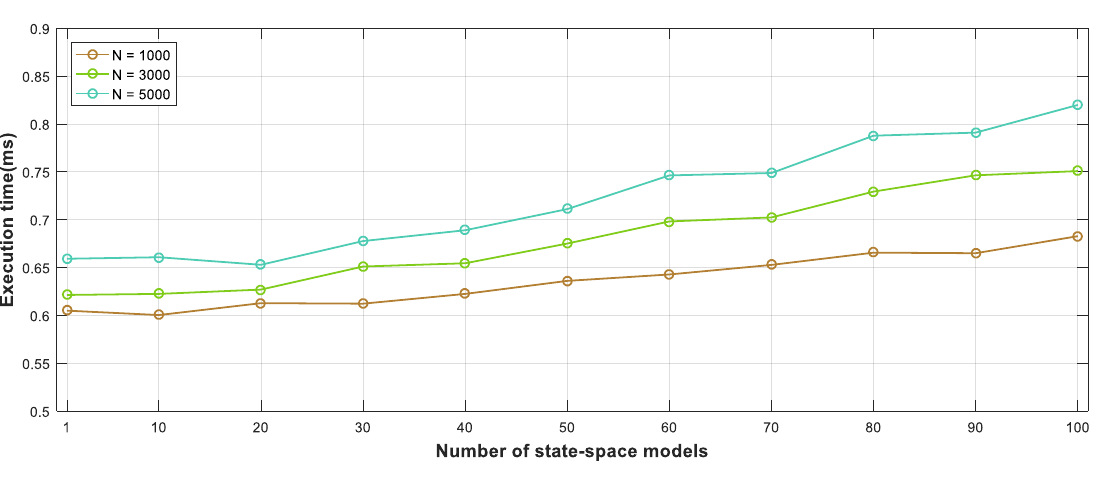
Figure 10. Execution time of algorithm according to the number of particles and state-space models. Table 3. Numberofthreadsandblocksandpartialexecutiontimeaccordingtonumberofstate-spacemodels. Number of Model Block Thread Time for PF Process (ms) Time for Copy Particles